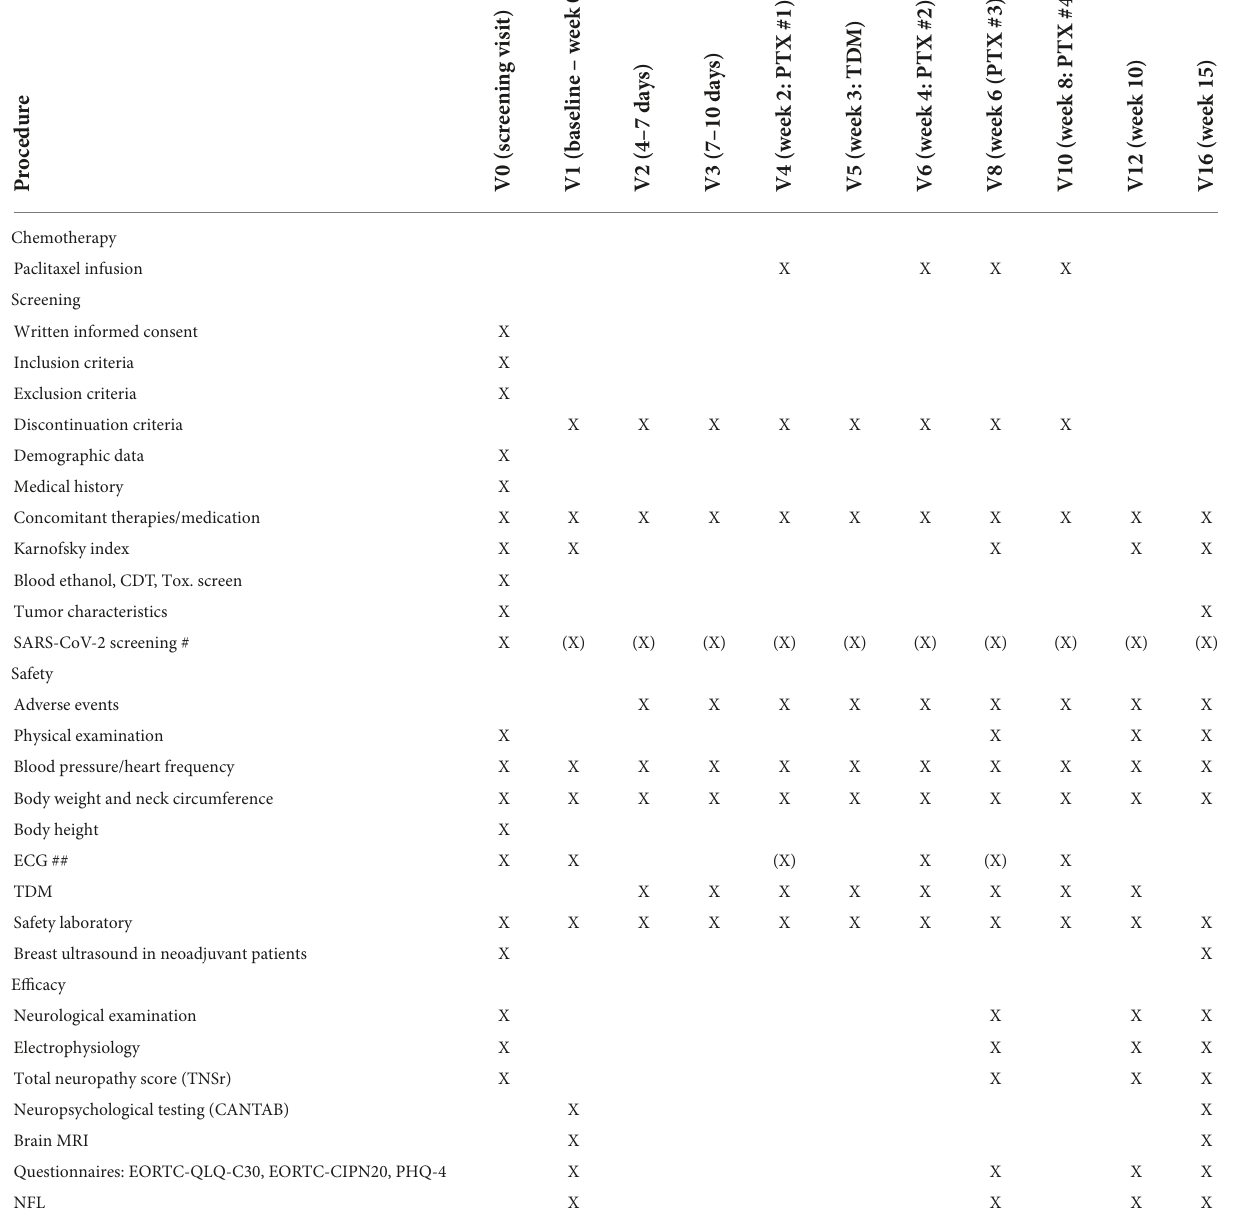
TABLE 3 Overview of study visits and relevant procedures per visit for patients receiving biweekly paclitaxel infusions (PTX q2w).